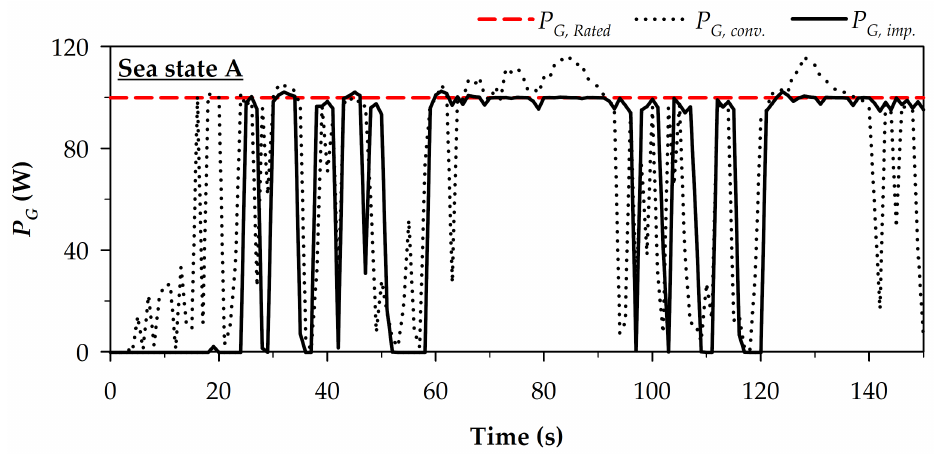
Figure 12. Comparison of P G generated from conventional and improved HPTO unit outputs in the sea state